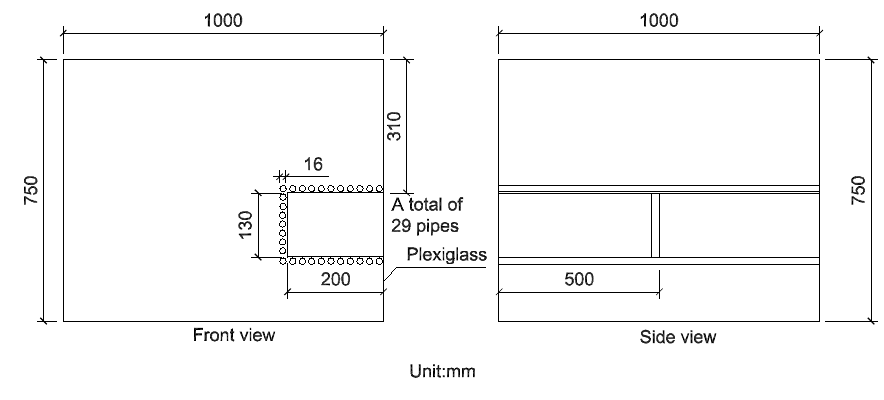
Figure 3. Localization of pipes in the box. Table 1. Physical and mechanical properties of the soil used in the study.